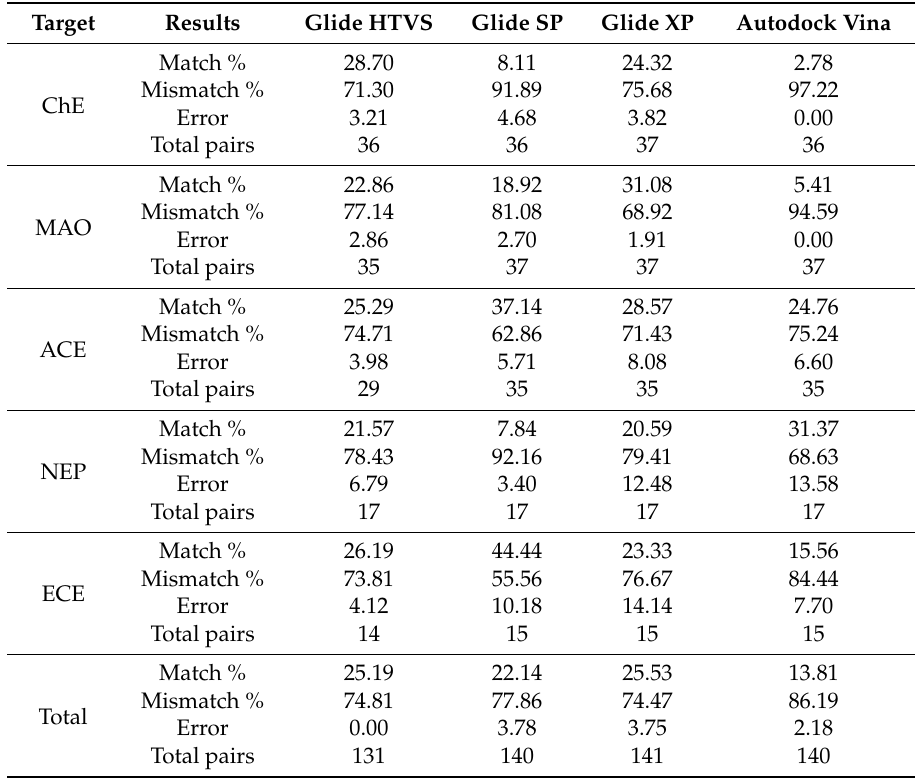
Table 1. Percentages of match and mismatch for the categories E , D R , or D S in the comparison between C A and C P for enantiomer